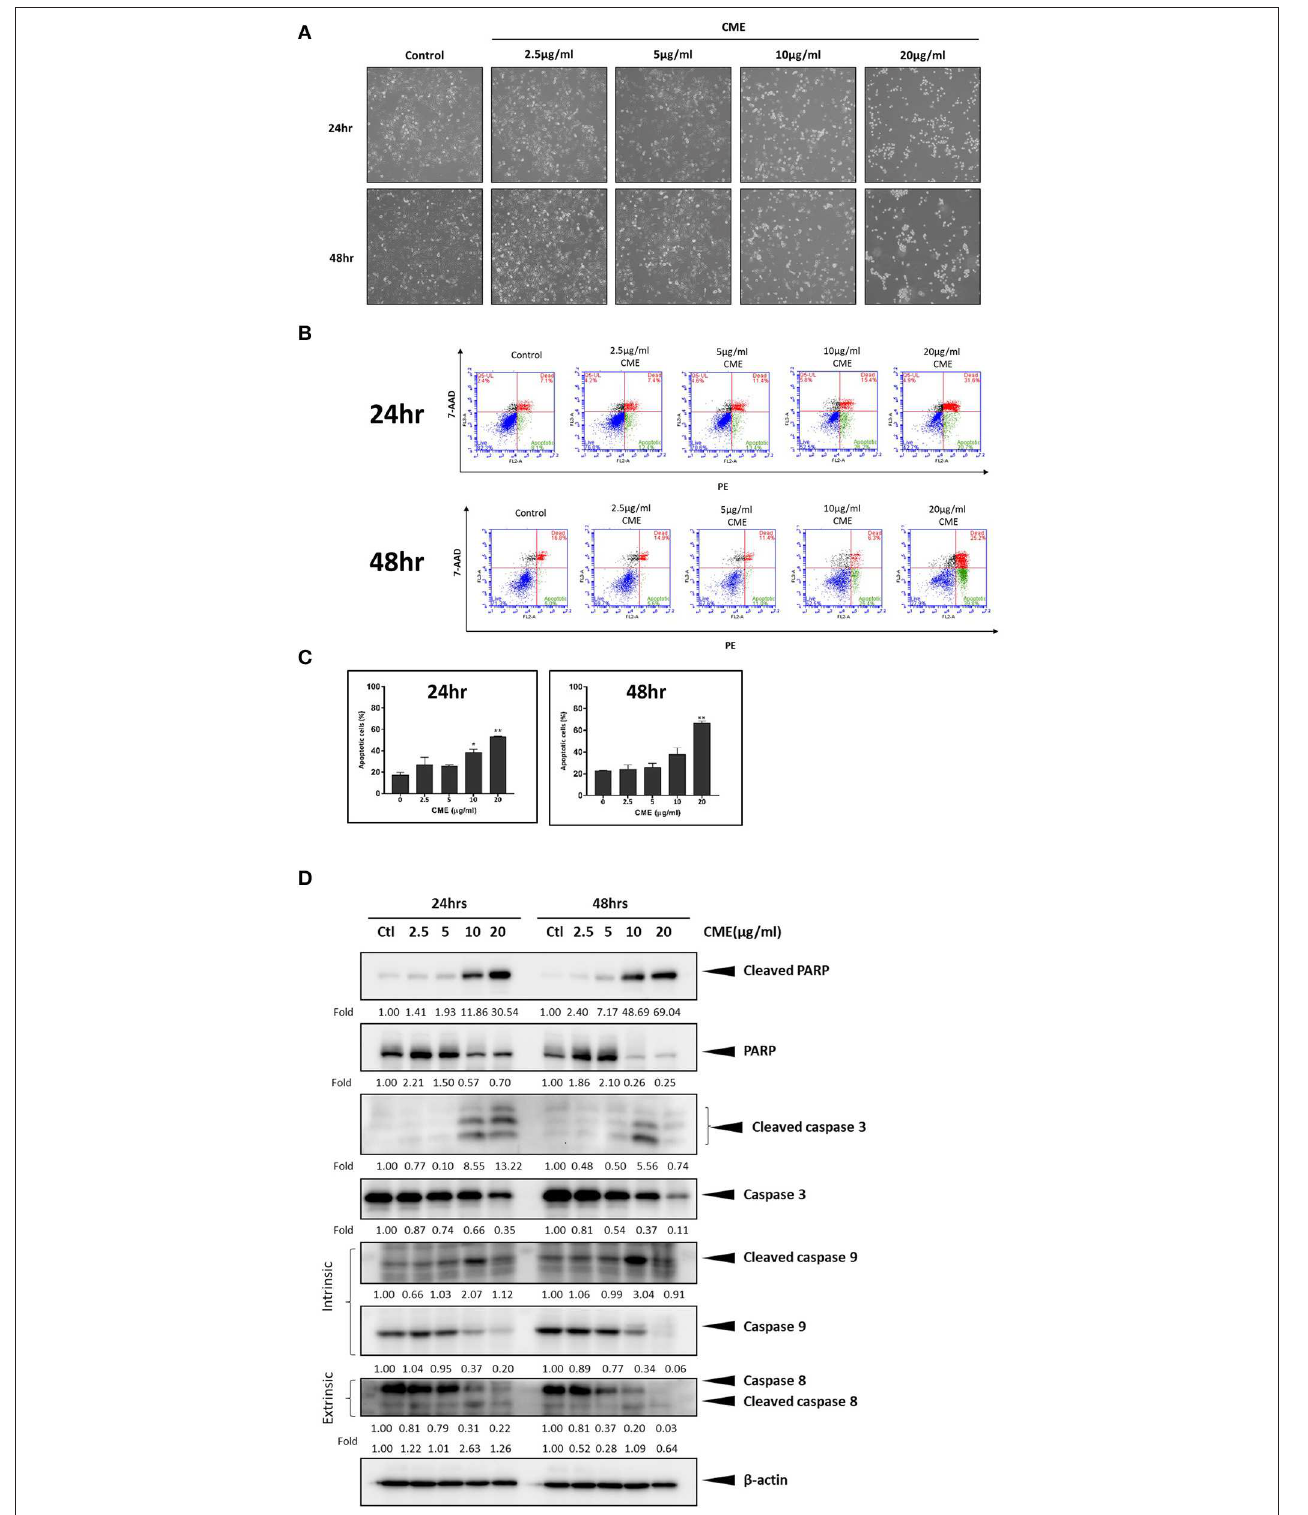
FIGURE 2 | CME induced apoptosis in MDA-MB-231 cells. Cells were treated with CME at the indicated concentrations for 24 and 48h. (A) Morphology of MDA-MB-231 cells was dramatically altered after 24h of treatment with CME. (B) Flow cytometry analysis of apoptosis in annexin V stained, CME-treated MDA-MB-231 cells. (C) Proportion of annexin V-positive MDA-MB-231 cells. (D) Western blot analysis of apoptosis related proteins. β -Actin was probed as the loading control. Data are presented as the means ± SD from three independent experiments. * P < 0.05 and ** P < 0.01 vs. control.